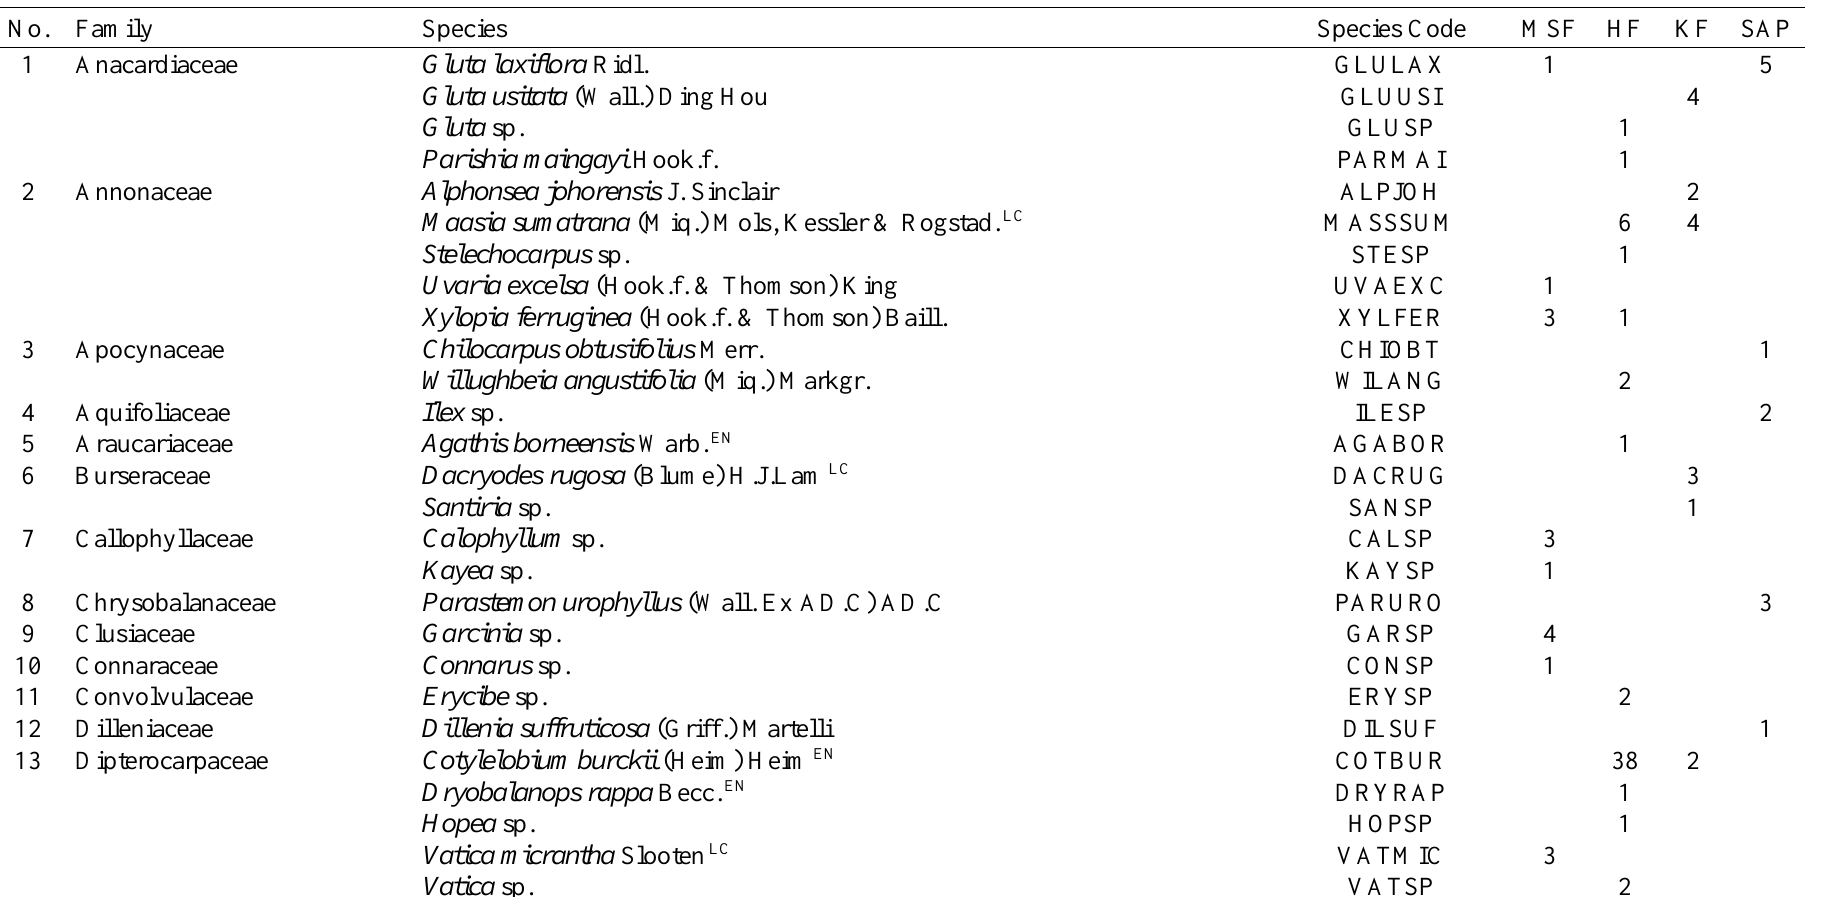
Table A1. Full checklist of censused woody seedlings (50 ≤ height (cm) ≤ 100) across the four forest types: mixed peat-swamp forest (MSF, n = 4 plots), heath forest (HF, n = 6 plots), kerapah (KF, n = 6 plots) and Shorea albida peat-swamp forest (SAP, n = 6 plots). Values are total seedling abundance for each species recorded per forest type. Superscript labels indicate the conservation status of the species according to the IUCN Red List (LC - Least Concern, NT - Near Threatened, VU - Vulnerable, EN – Endangered) (IUCN